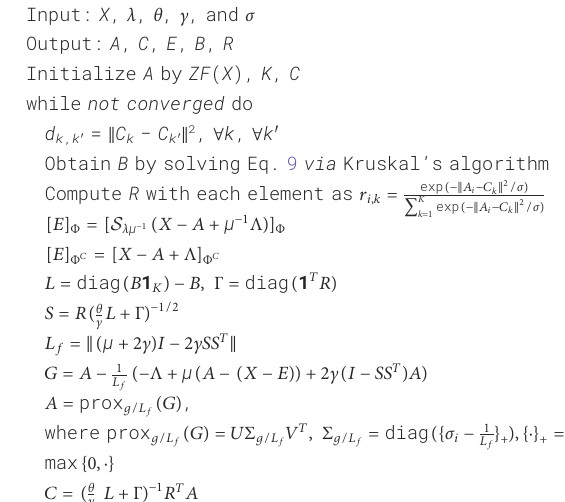
Algorithm 3. The exact RobustTree algorithm